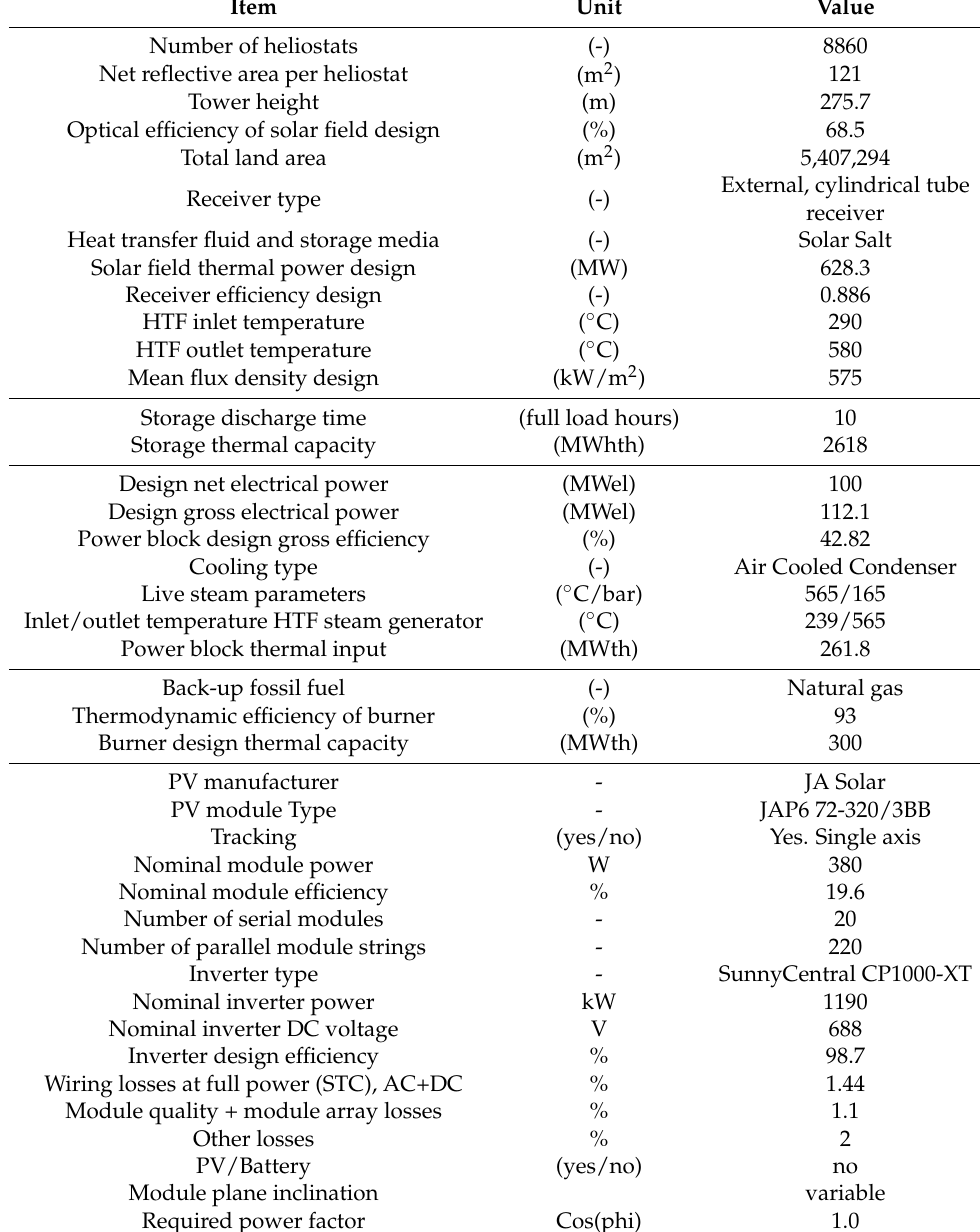
Table 3. Main technology data for CP3 with solar multiple =